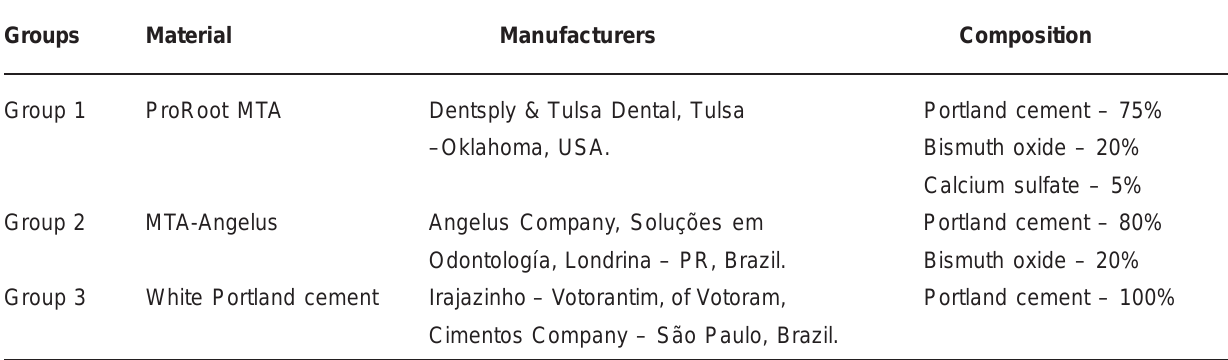
TABLE 1- Distribution of experimental material, manufacturers and composition